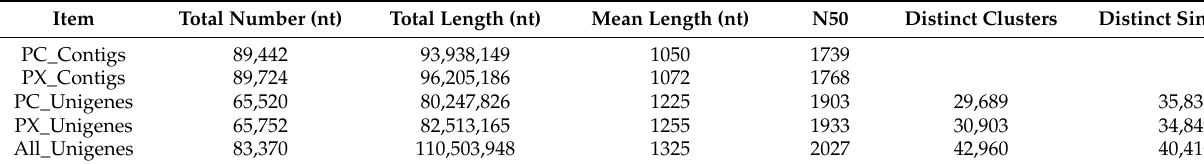
Table 2. Quality of the assembled RNA sequencing data.